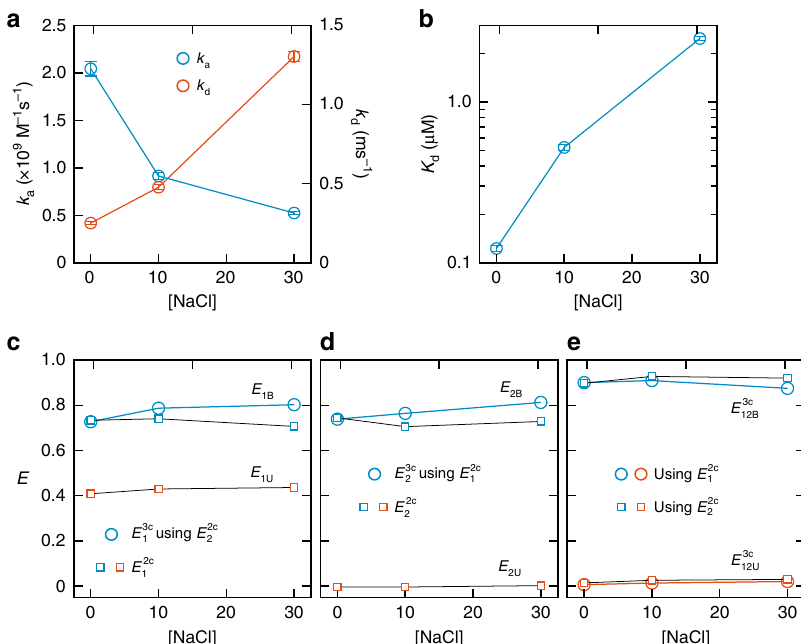
Fig. 5 FRET ef fi ciencies and kinetics parameters of TAD-NCBD binding. a Bimolecular association rate constant k a = k B /[NCBD] (blue) and dissociation rate constant k U (red) obtained from the extracted relaxation rate, k = k B + k U , and the bound fraction, p B = k B / k . k B is the apparent binding rate constant. b Dissociation constant, K d ( = k U / k a ). c – e Measured FRET ef fi ciencies of the bound and unbound states. c E 1 2c (blue square, bound; red square, unbound) and E 1B 3c (blue circle) calculated using E 2B 2c . d E 2 2c (blue square, bound; red square, unbound) and E 2B 3c (blue circle) calculated using E 1B 2c . e E 12 3c (blue, bound; red, unbound) calculated using two-color FRET ef fi ciencies E 1 2c (circle) and E 2 2c (square). Error bars are standard deviations calculated from the curvature at the maximum of the likelihood function. Source data are provided as a Source Data fi